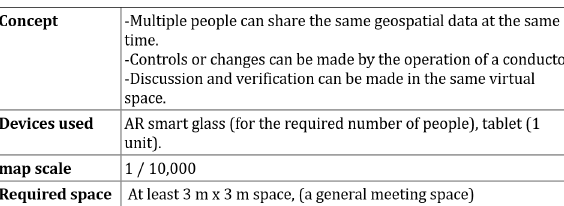
Table 3. Concept and Requirements of the Prototype System